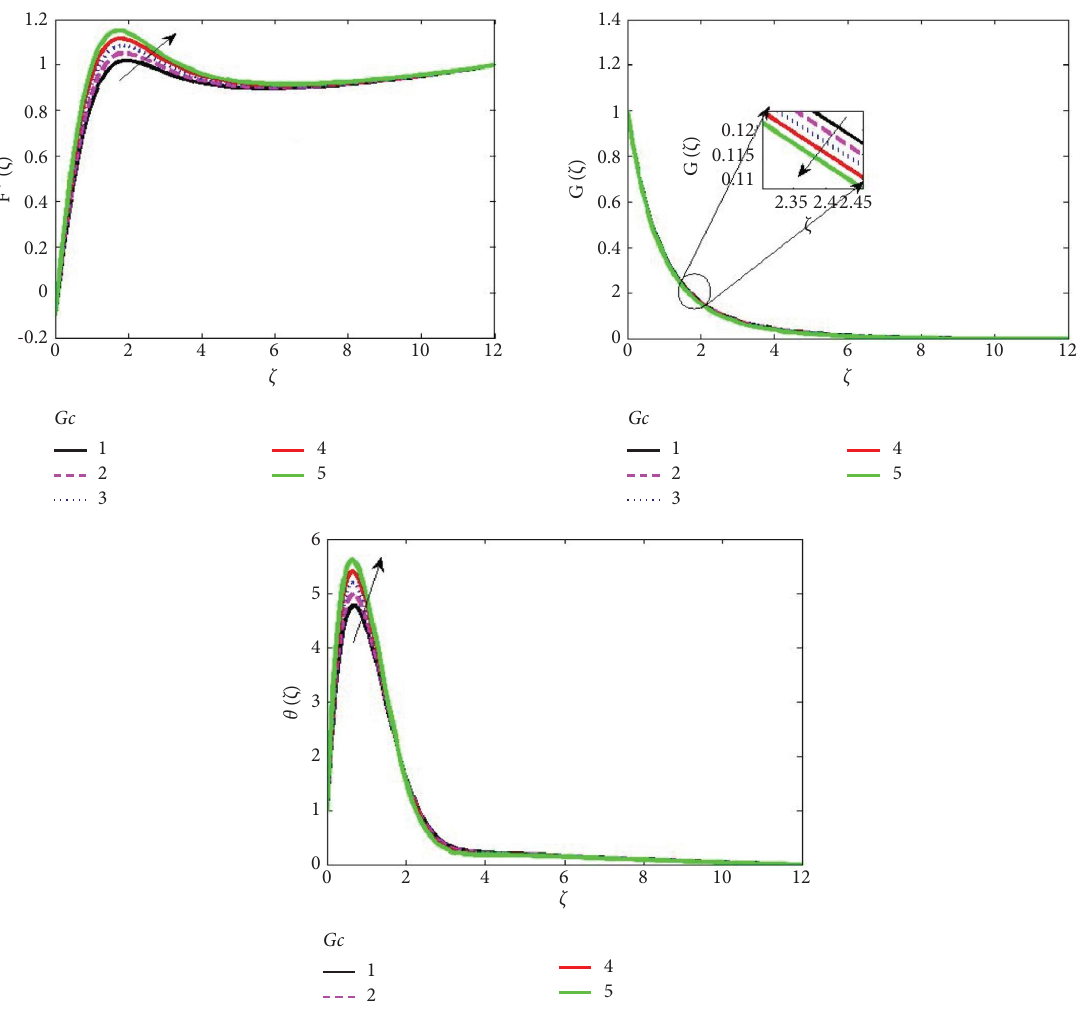
Figure 7: Efect of the Rayleigh number on the velocity, azimuthal velocity, and